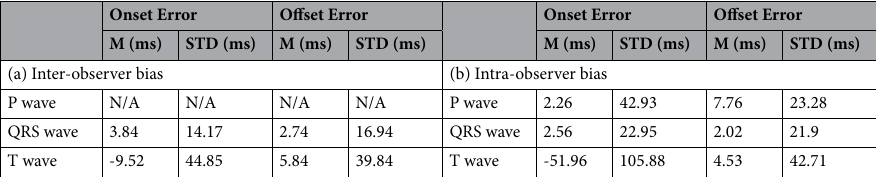
Table 3. Onset and offset errors (mean, M ± standard deviation, SD) of the inter-observer ( a ) and intra- observer ( b ) bias within matching delineations in the ground truth. No P wave annotations were produced by the second observer.